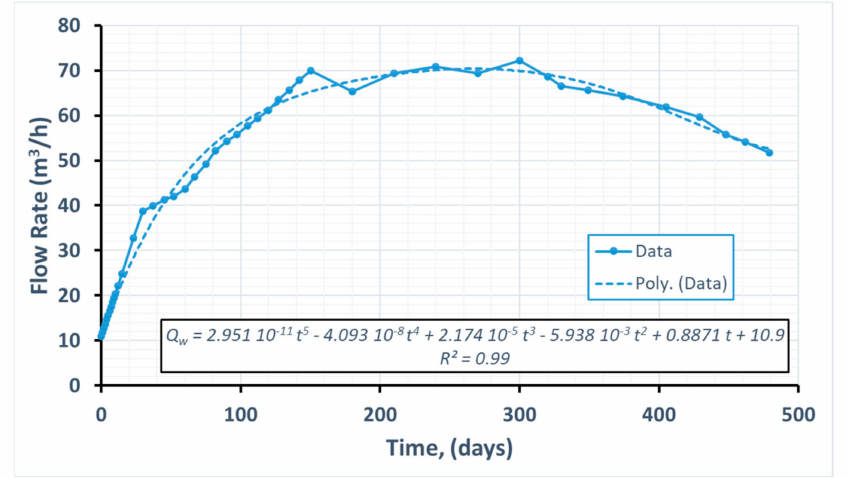
Figure 16. The change over time in the total flow rate (productivity) Q w calculated on the producer wells. This productivity curve serves to estimate the time duration of an extraction block and fits more or less to a 5th-order